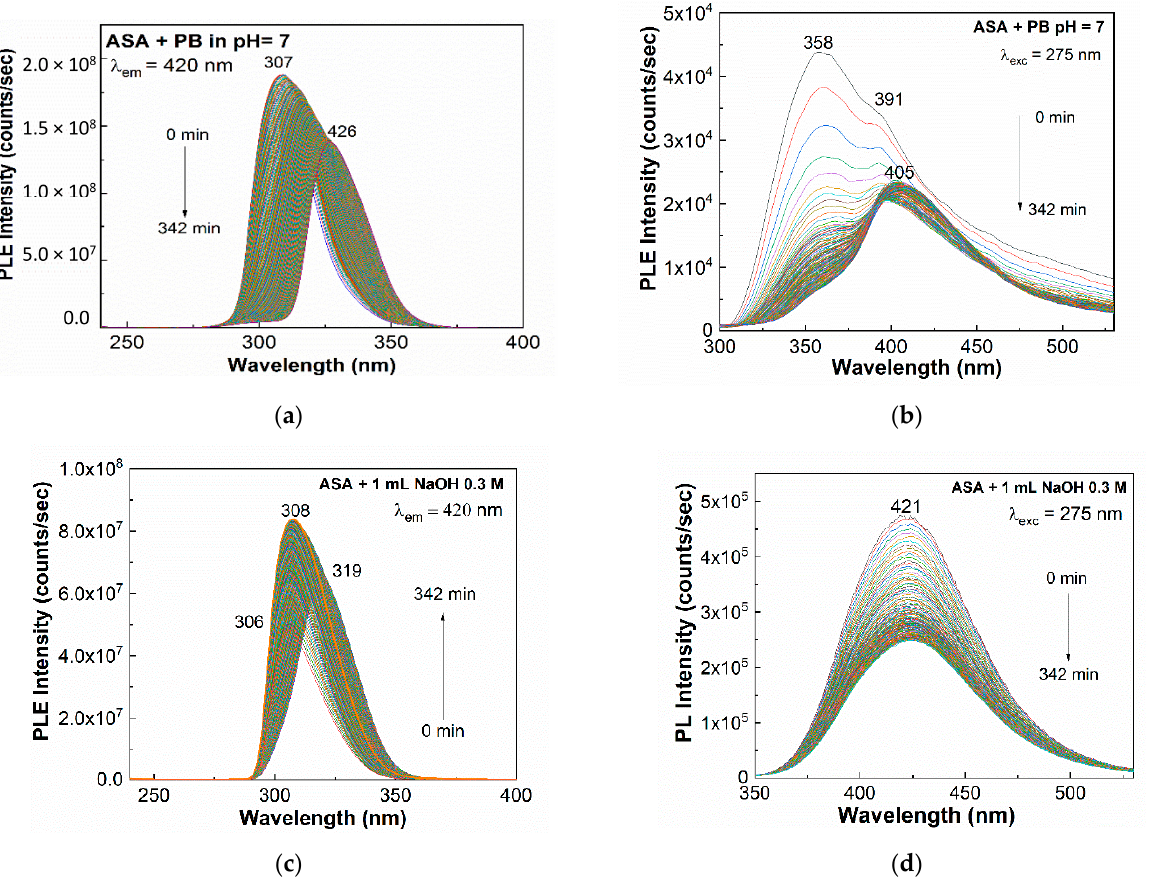
Figure 3. PLE and PL spectra of ASA in the presence of phosphate buffer (PB) with pH = 7 ( a , b , the ASA concentration was 0.3 M) and after the interaction of 2 mL ASA 0.3 M with 1 mL NaOH 0.3 M ( c , d ). All PLE and PL spectra were recorded under the emission wavelength equal to 420 nm and the excitation wavelength equal to 275 nm, respectively.